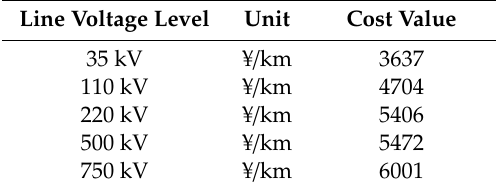
Table 2. Transmission Line of the risk maintenance resource costs (RMRC).